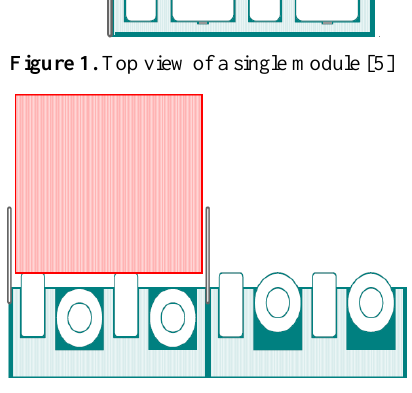
Figure 2. Guidelines in the ascended state [5]